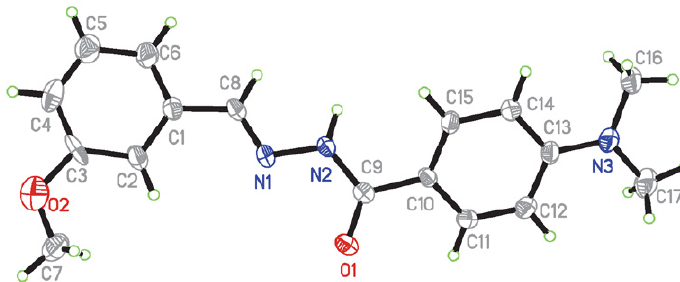
Figure 3. The molecular structure of 3 . The ellipsoids are shown with 30%